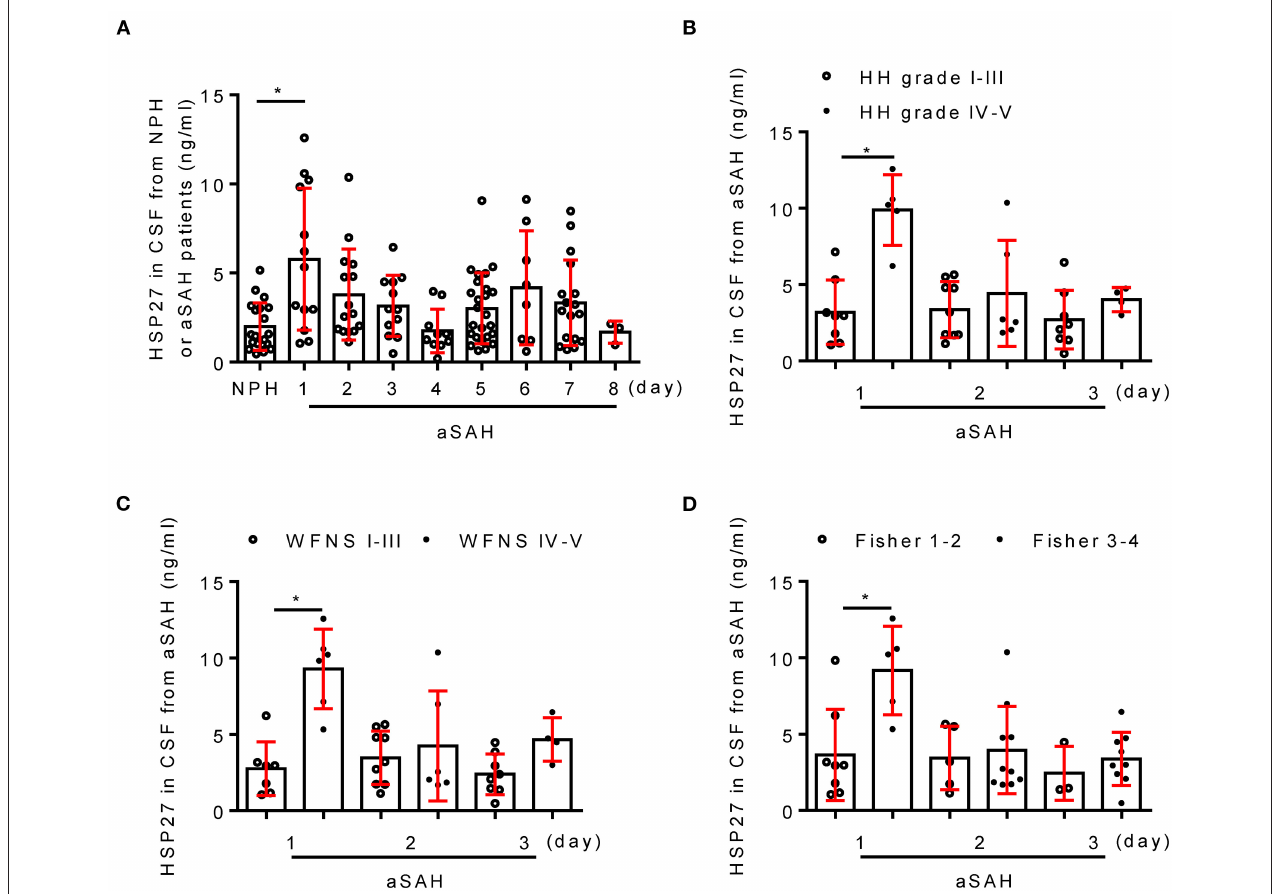
FIGURE 1 | Change of CSF HSP27 level in patients with aSAH. (A) Concentration of CSF HSP27 of patients with NPH and aSAH is measured at indicated time with HSP27 ELISA Kit. The histogram shows CSF HSP27 level of patients with aSAH with HH grades I–III and IV–V (B) , WFNS grades I–III and IV–V (C) , Fisher score 1–2 and 3–4 (D). The values are expressed in ng/ml. Data are mean ± SD, * p < 0.05, ANOVA with Bonferroni’s multiple comparisons test.